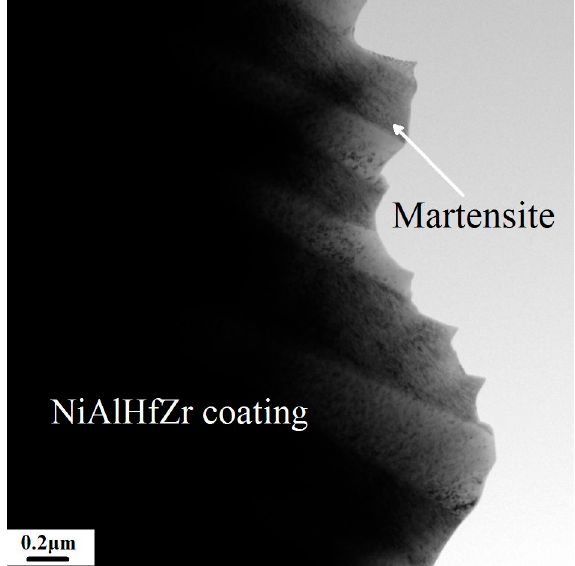
Figure 12. The cross-sectional TEM morphology of NiAl–Hf–Zr coating on the N5 superalloy after 100 h cyclic oxidation at 1150 °C.